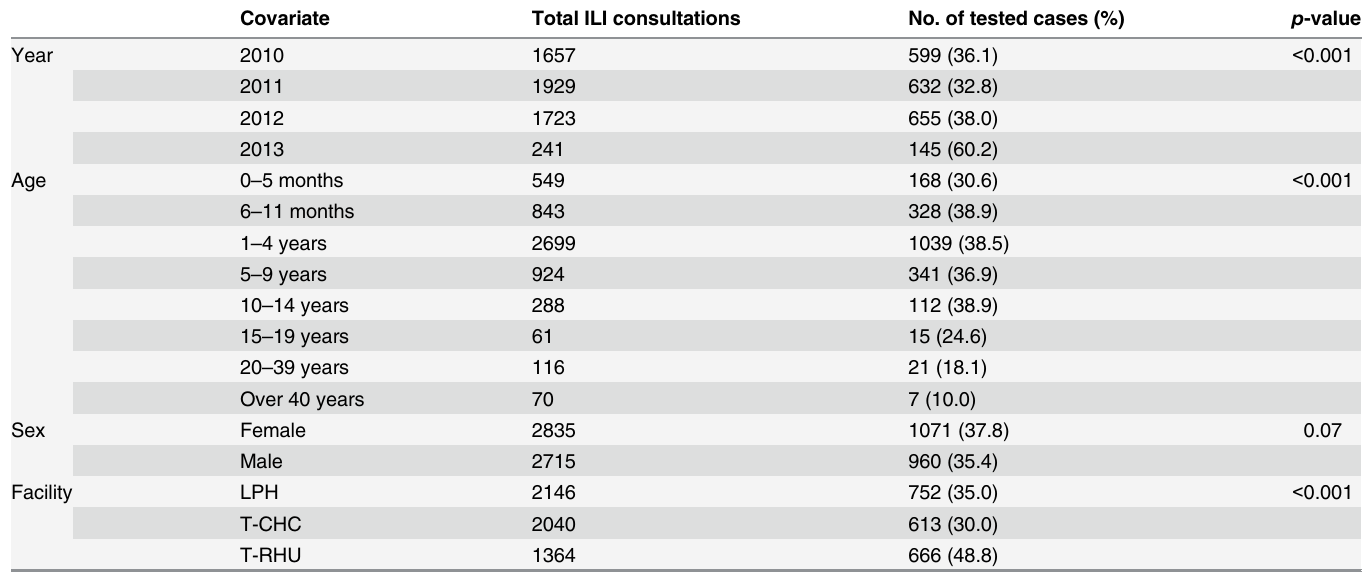
Table 1. Demographic characteristics of all influenza-like illness (ILI) cases and the tested cases from 2010 to 2013. Covariate